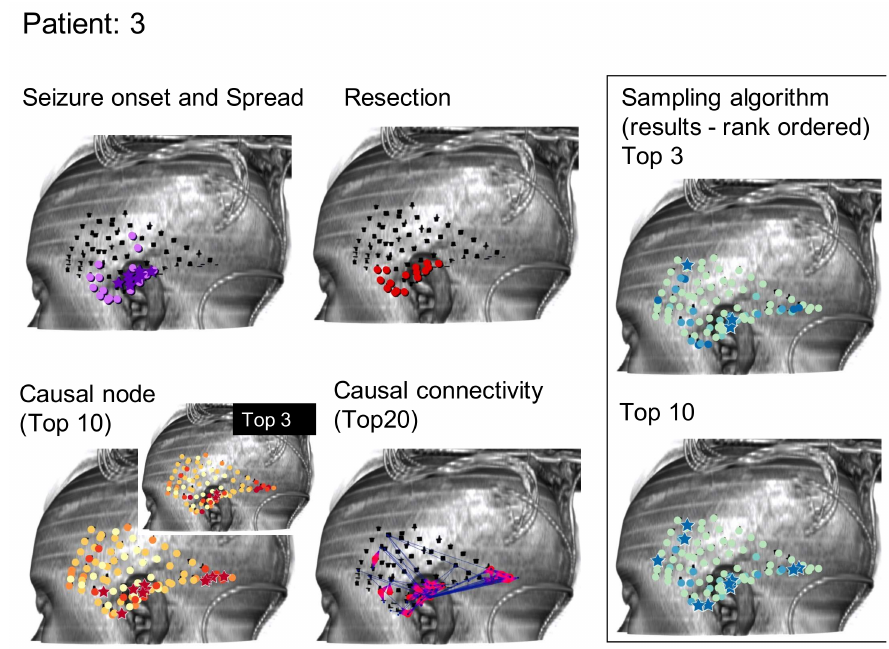
Figure 3. Similar to Figure 2, results for the Monte Carlo sampling algorithm (1000 random restarts, 1000 samples per random restart) run on one patient are